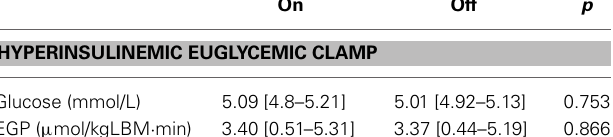
Table 2 | Clamp measurements.